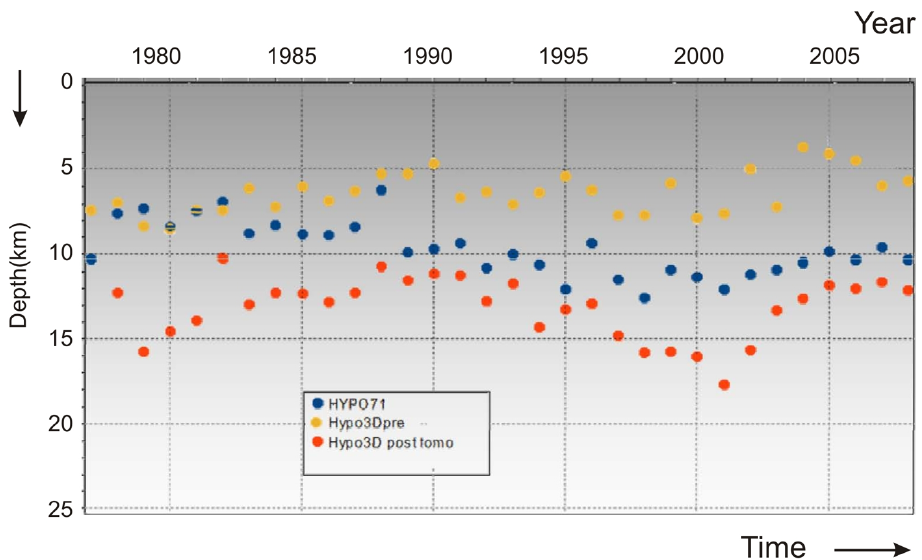
Figure 15. Time evolution of the average hypocenter depth using different algorithms and models. Blue dots, Hypo71 in a 1D model; yellow dots, Hypo3D in the 3D model in Figure 2; orange dots, Hypo3D in the 3D model obtained by the tomographic inversion displayed in Figures 9 and 10.